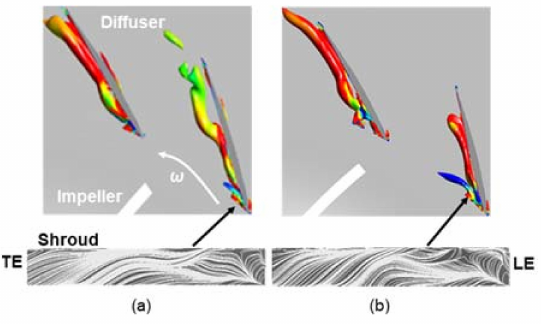
Figure 18. Unsteady behavior of vortices (SVD, ϕ = 0.7 Q d ): ( a ) t = t s0 ; ( b ) t = t s1